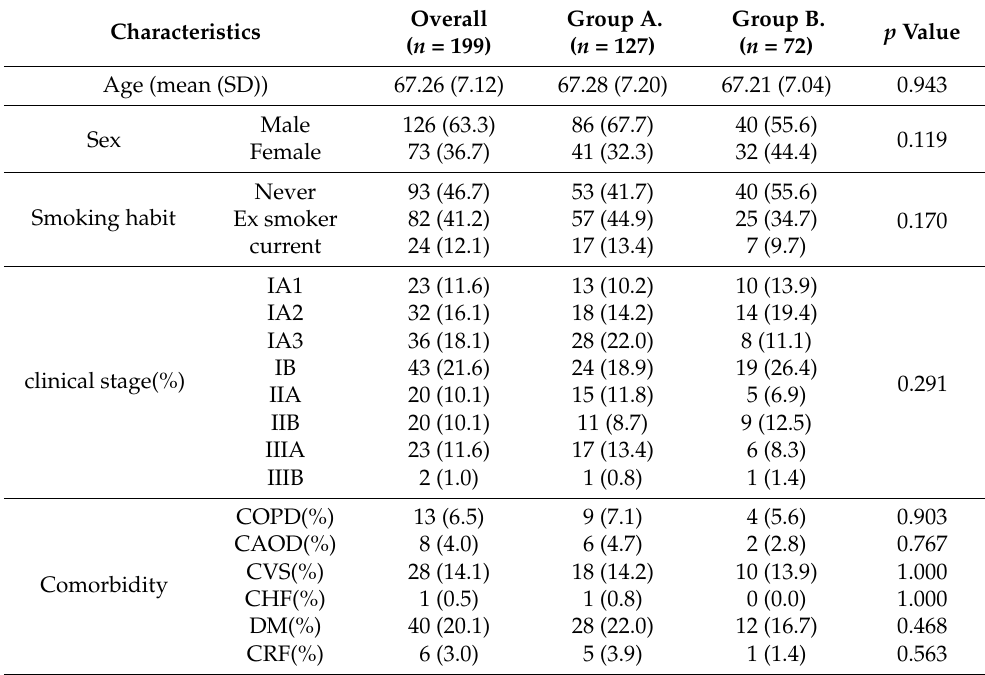
Table 1. Patient characteristics of group A vs. group